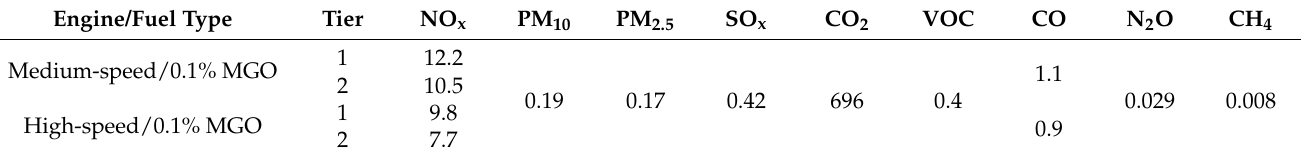
Table 5. AE emission factors (g/kWh) for hoteling, Port of Los Angeles 2020